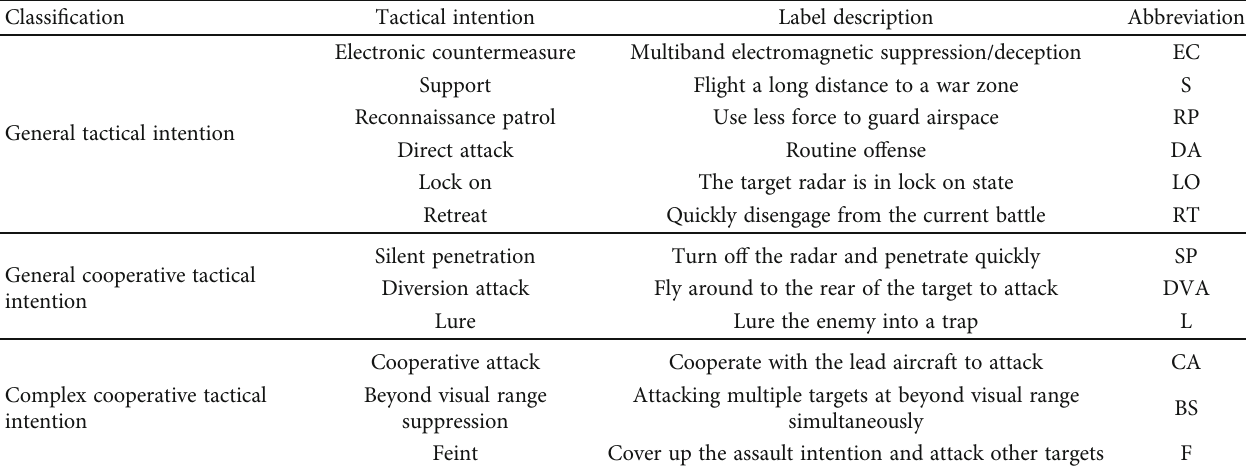
Table 2: Label set for cooperative tactical intention.